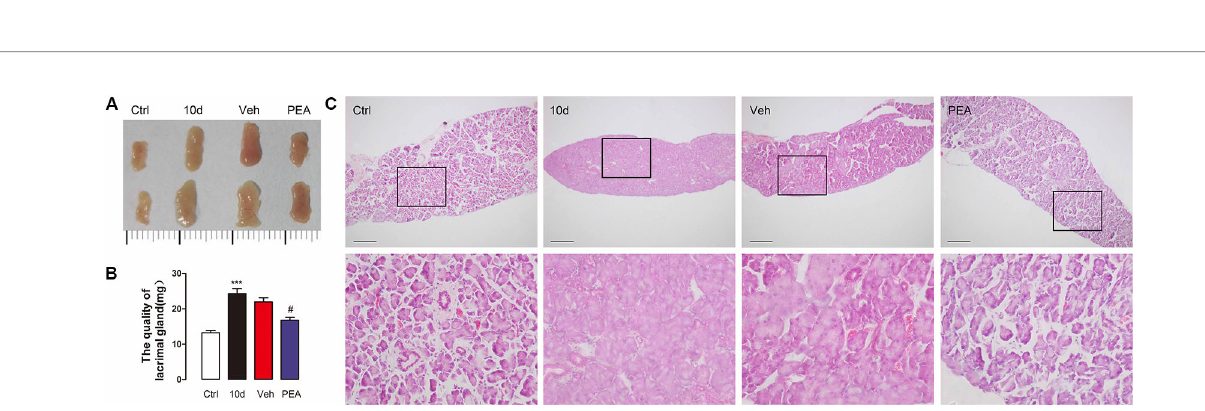
FIGURE 5 | PEA normalized the morphological feature of LG. The increased size (A) , weight (B) , and acini size (C) of LG returned to normal levels after PEA treatment. ***, P < 0.001 vs. control group; # , P < 0.05 vs. vehicle group, one-way ANOVA followed by Dunette ’ s post hoc , n =